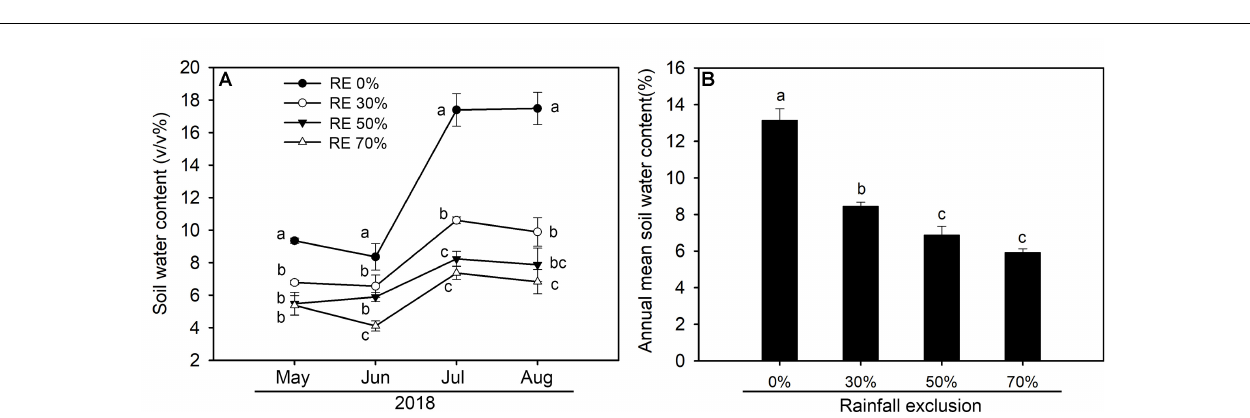
and Supplementary Figure S2B ), respectively. AMF did not affect belowground biomass except in L. chinensis under the RE50% treatment. Significant AMF effects on the